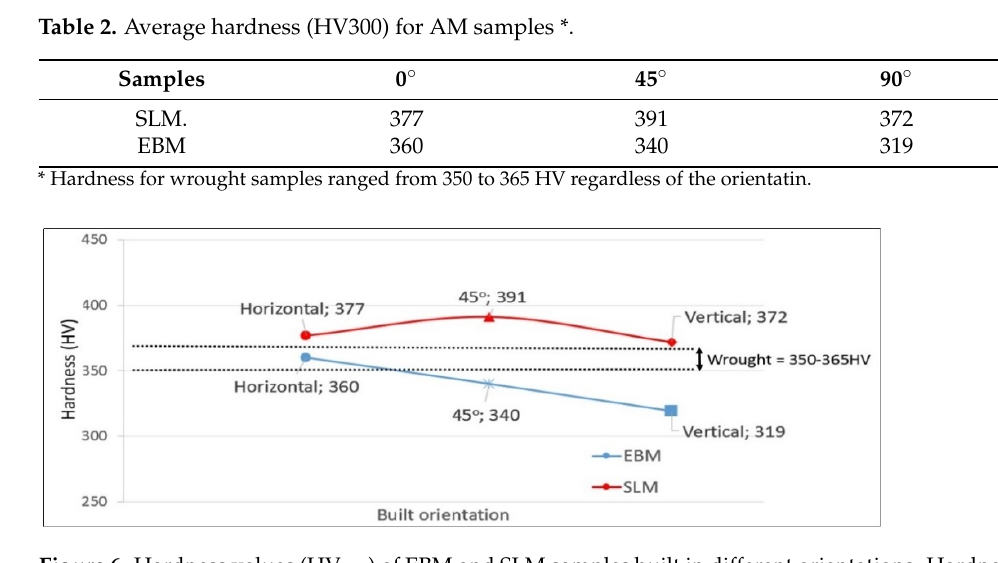
Figure 6. Hardness values (HV 300 ) of EBM and SLM samples built in different orientations. Hardness values of wrought samples are indicated.